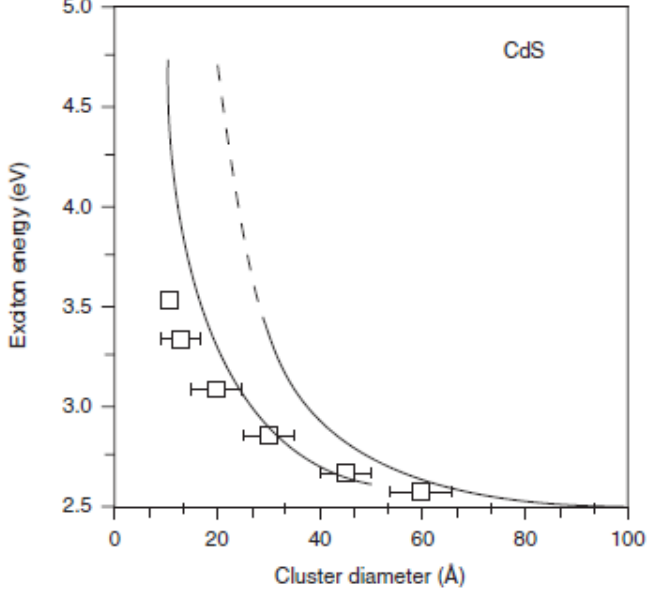
Figure 7. Experimentally and theoretically determined band-gap as a function size of CdS Qdots. Broken line: calculated parameters based on effective mass approximation, solid-line: tight-bonding calculation; squares: experimental data (Reprinted with permission from [60]. Copyright 1991 American Chemical